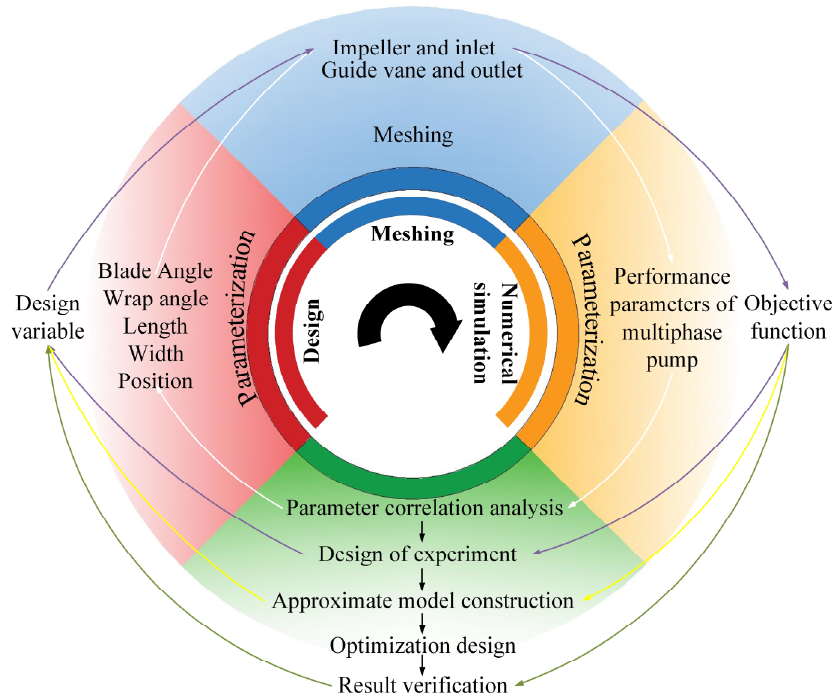
Figure 2. The flow chart of the integrated optimal design approach.